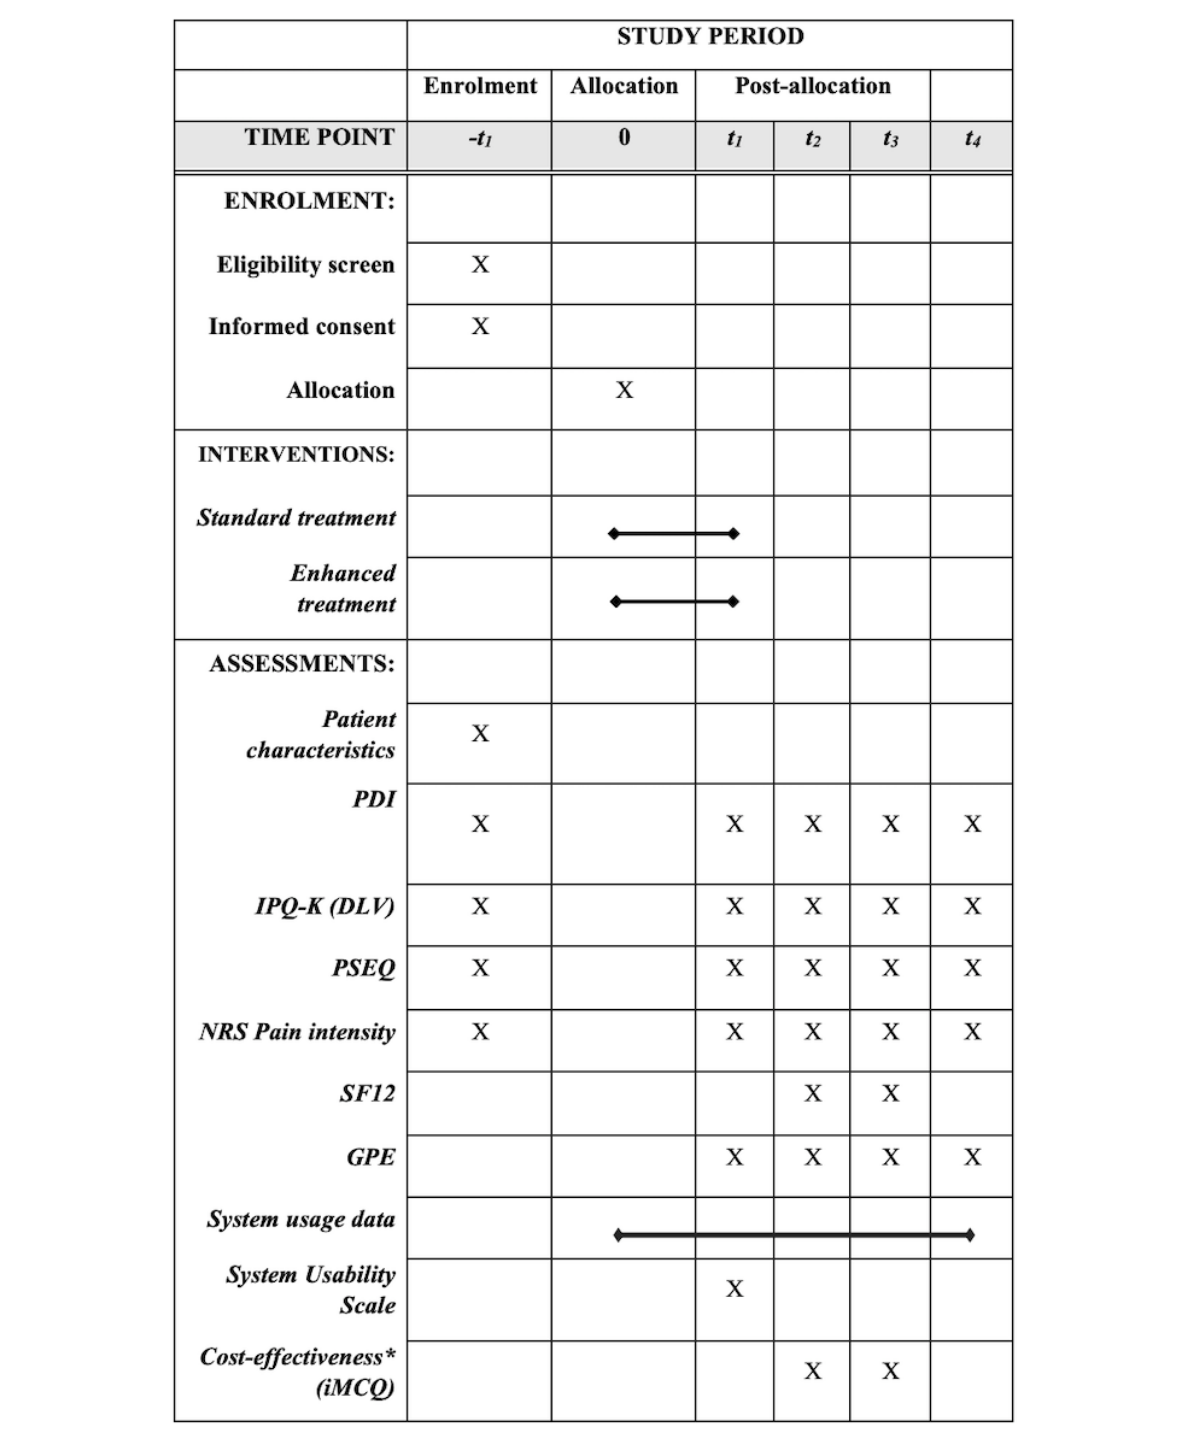
Figure 2. Schedule of enrollment, interventions, and assessments. Adopted from SPIRIT (2013). -t1: prior to treatment; t1: posttreatment; t2: 3 months posttreatment; t3: 6 months posttreatment; t4: 12 months posttreatment; PDI: pain disability index; IPQ-K (DLV): Dutch language version of the Illness Perception Questionnaire; PSEQ: Pain Self-Efficacy Questionnaire; NRS: numeric rating scale; SF12: 12-item short-form health survey; GPE: global perceived